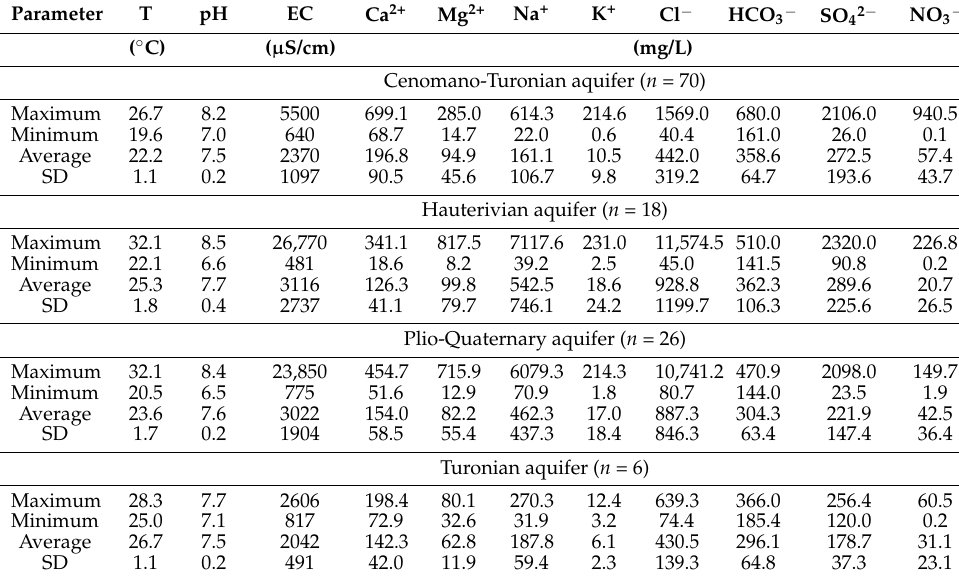
Table 1. Statistical results of the analyzed samples (campaign of